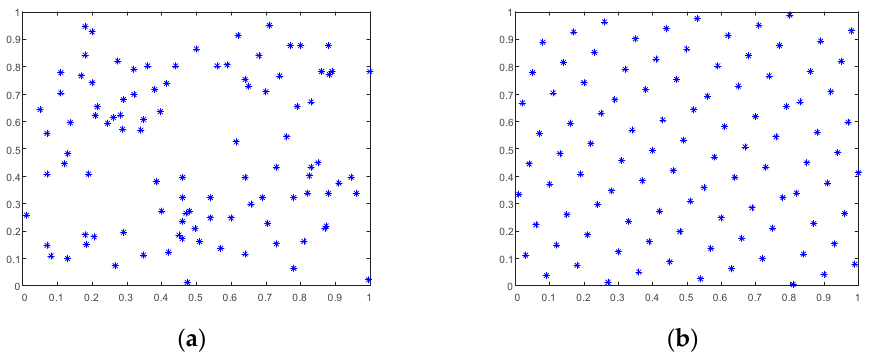
Figure 6. Point sets generated by ( a ) random method; ( b ) Halton sequence.